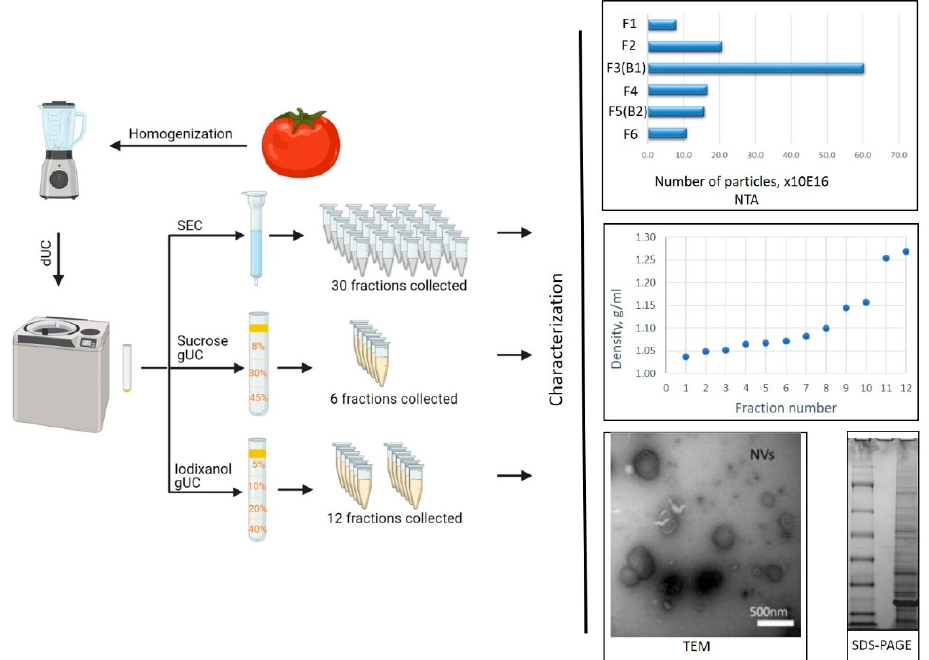
Figure 1. Isolation, physical and molecular characterization of tomato nanovesicles (NVs). Briefly, tomatoes were homogenized in a homogenization buffer, and differential centrifugation (dUC) was applied to isolate the bulk NVs. NVs were purified by size-exclusion chromatography (SEC) or separated into different fractions, using gradient-density ultracentrifugation (gUC). Particle concentration, size distribution, morphology, density and molecular features were analyzed to confirm the membrane vesicle character of the samples [14]. Inserts from top to the bottom show the particle number distribution in the sucrose gUC fractions performed by nanoparticle tracking analysis (NTA), density curve of the iodixanol gUC fractions, electron microscopy images and SDS–PAGE profile of crude tomato NVs. (Figure was created by using Biorender [47].)